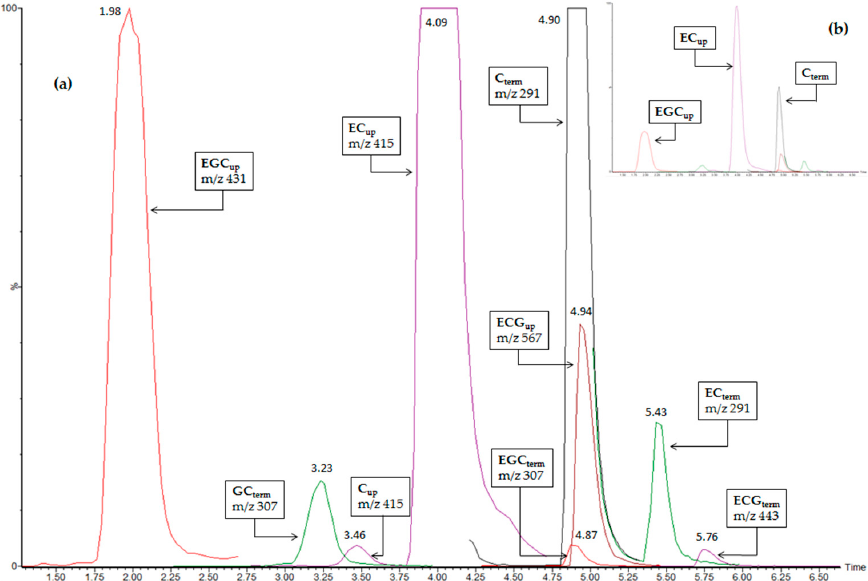
Figure 2. Superimposition of MRM traces from the UHPLC-QqQ-MS analysis of proanthocyanidin units of a grape skin extract after phloroglucinolysis; ( a ) 4× zoomed display; ( b ) full display.